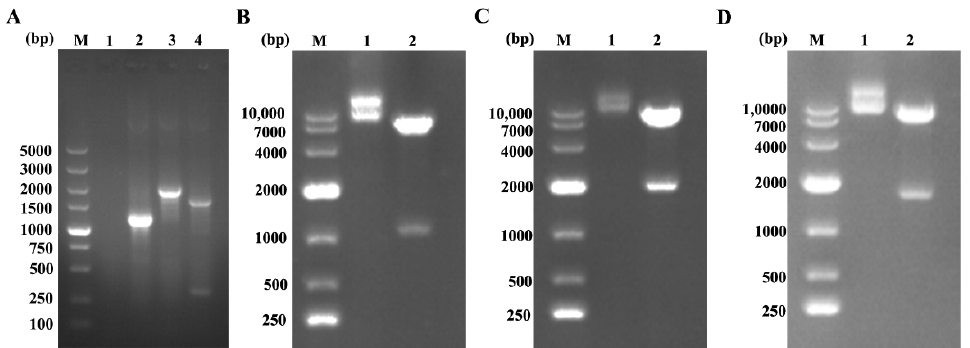
Figure 2. The recombinant plasmids were identified by PCR and restriction enzyme with Nhe I and BamH I/Not I. ( A ) The recombinant plasmids were identified by PCR. M: 5K DNA